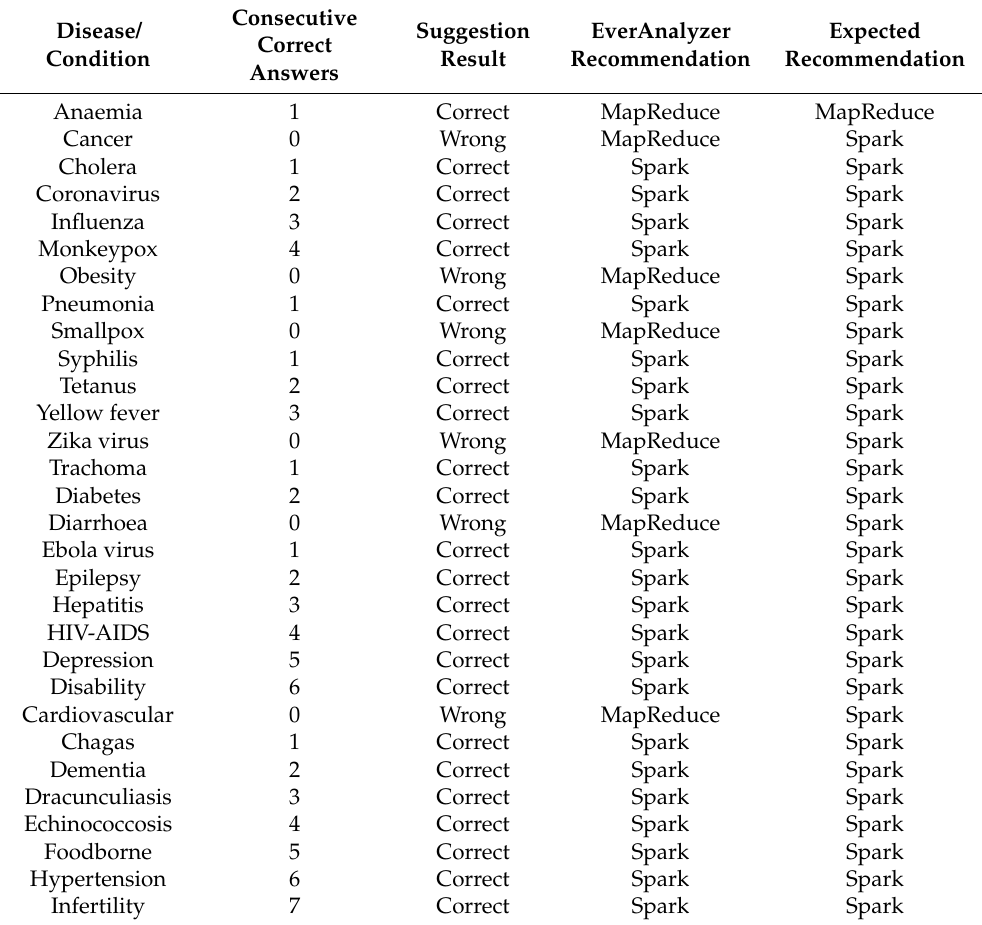
Table 5. Processing